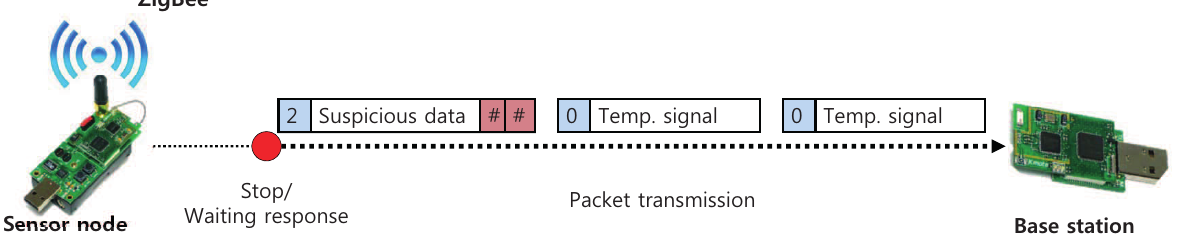
Table 1 indicates the elapsed time and power consumption of the two algorithms in the sensor